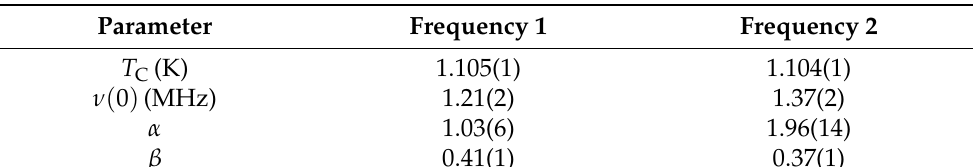
Table 1. Parameters for fitting the temperature dependence of the precession frequencies to